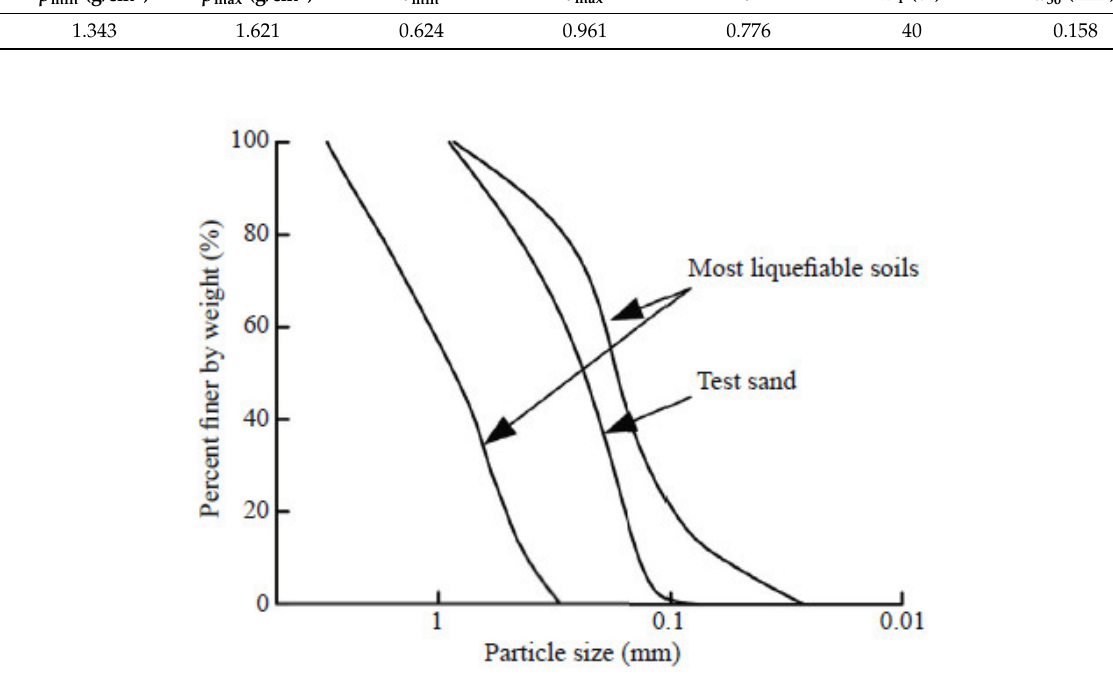
Figure 1. Particle size distributions of the XiFeng standard